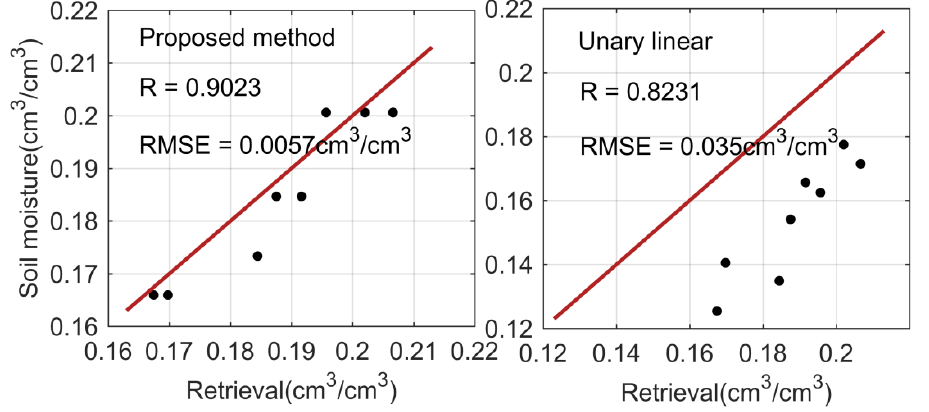
Figure 14. Scatter diagram of the retrieval soil moisture.